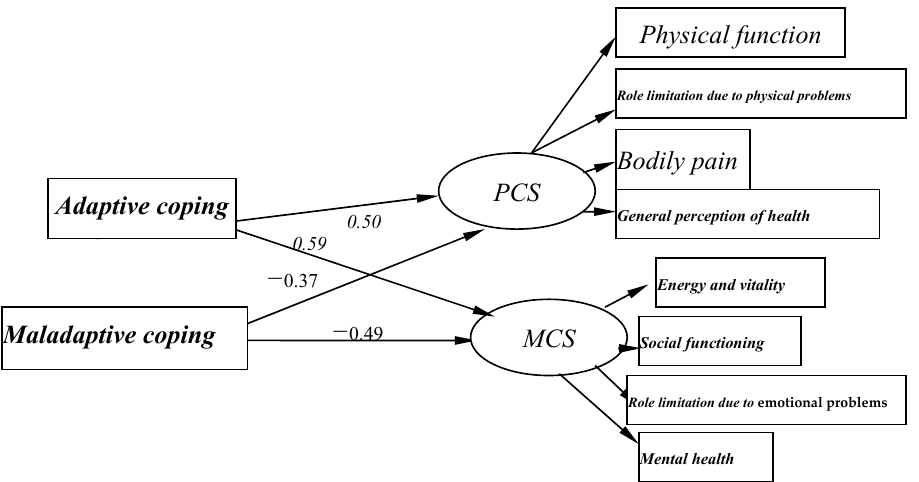
Figure 1. Structural equation modeling of coping and QOL (PCS and MCS).